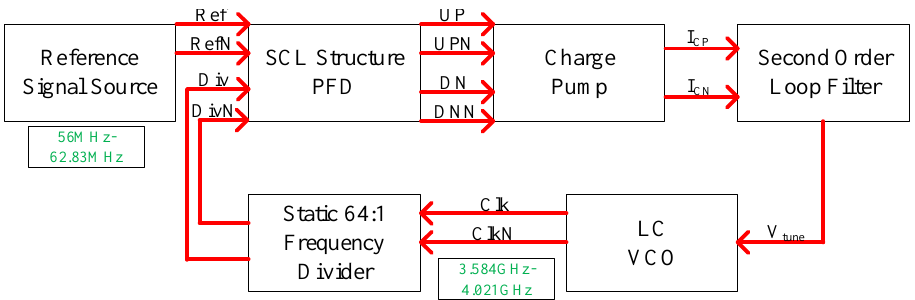
Figure 1. The system architecture of CPPLL.